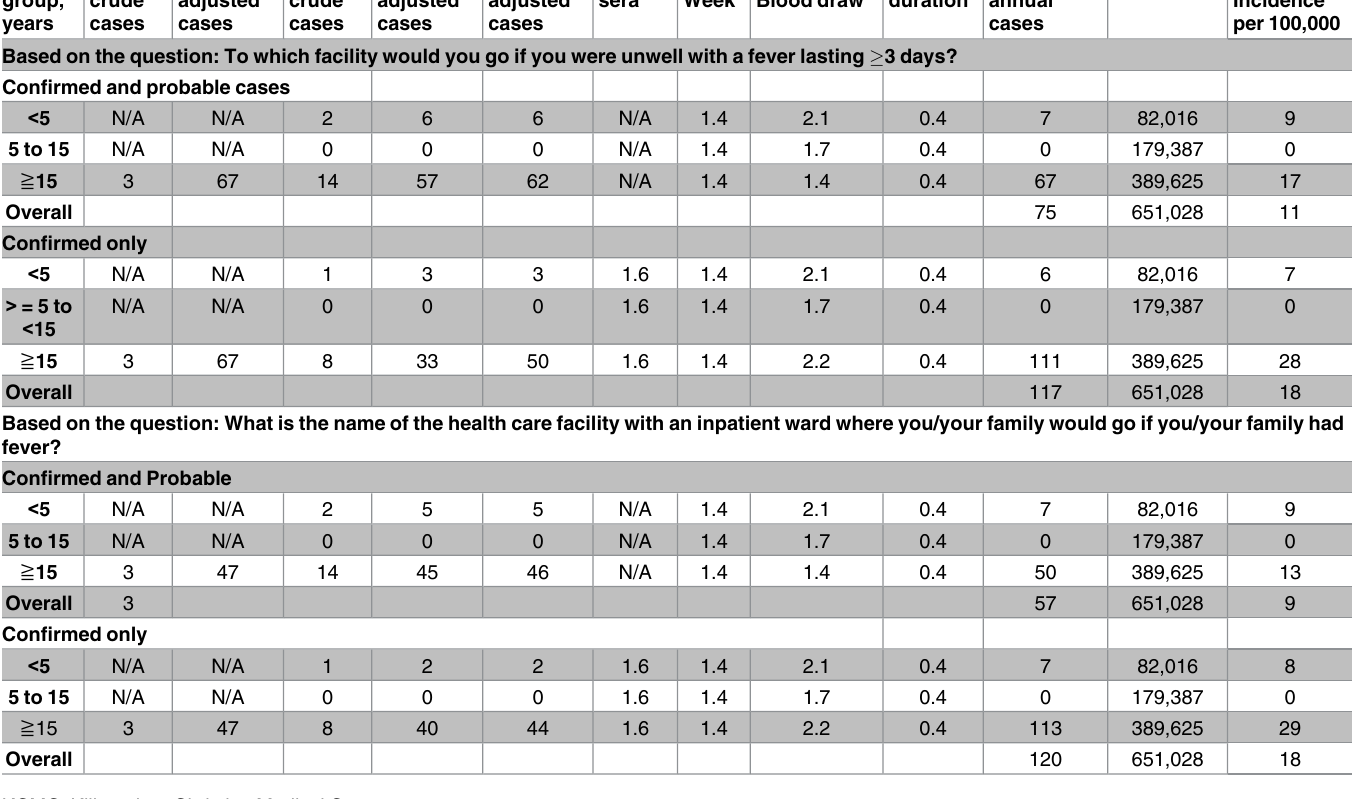
Table 5. Calculation of incidence of acute leptospirosis, Moshi Rural and Moshi Urban Districts, Tanzania, 2012–14. Age group,